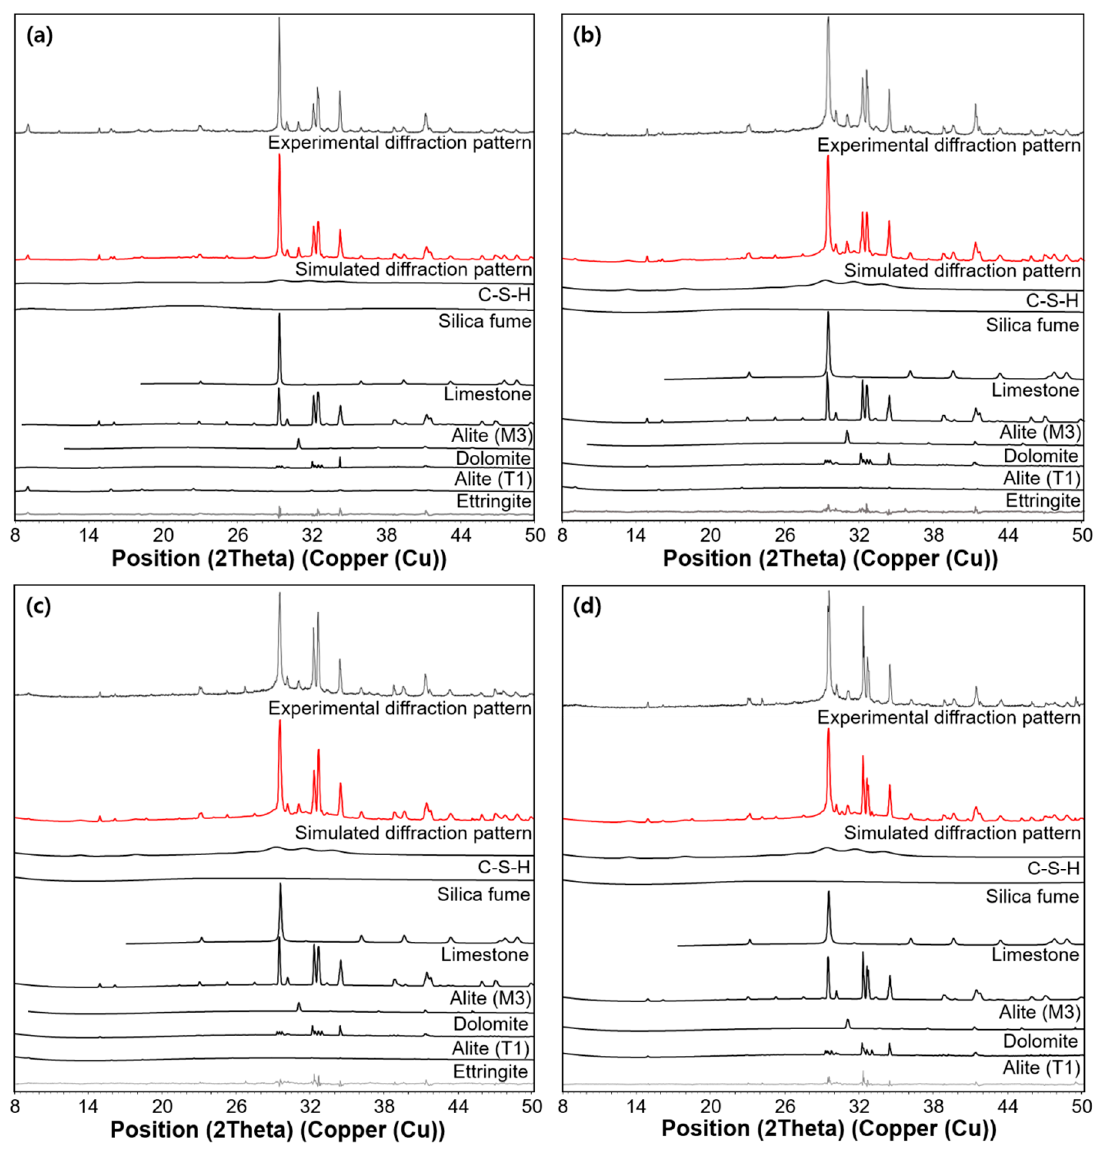
Figure 7. Rietveld refinement results of all samples: ( a ) UHPC_1 day, ( b ) UHPC_2 days, ( c ) UHPC_4 days, ( d ) UHPC_28 days .